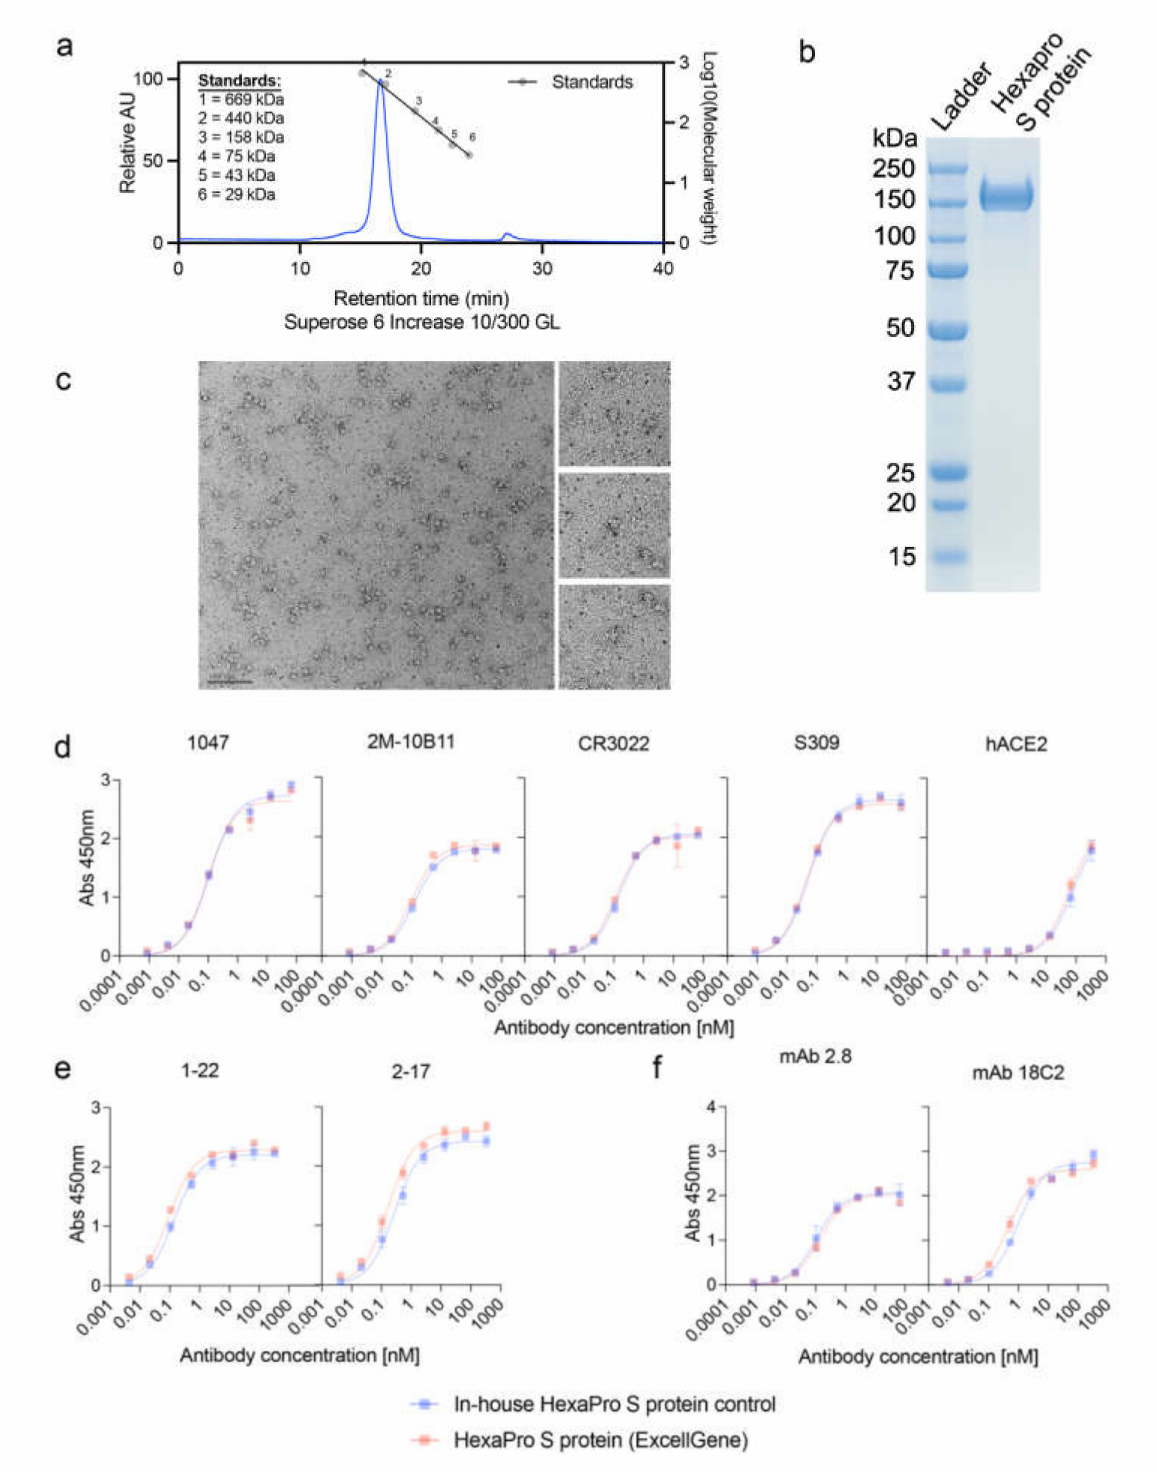
Figure 1. Characterization of the SARS CoV-2 HexaPro S protein. ( a ) Analysis of HexaPro S protein on size-exclusion chromatography (SEC), with a single peak at 16.6 min and purity of 98%. A mixture of thyroglobulin (669 kDa), ferritin (440 kDa), aldolase (158 kDa), conalbumin (75 kDa), ovalbumin (43 kDa), and carbonic anhydrase (29 kDa) proteins were used as standards. ( b ) SDS-PAGE gel showing a band for the HexaPro S protein. ( c ) Negative-stain electron microscopy (Bar = 100 nm) of the HexaPro S protein. Antibody binding to ( d ) RBD (1047, 2M-10B11, CR3022, S309, and hACE2), ( e ) N-terminal domain (NTD; 2-17 and 1-22), and ( f ) S2 subunit (mAb 2.8 and mAb